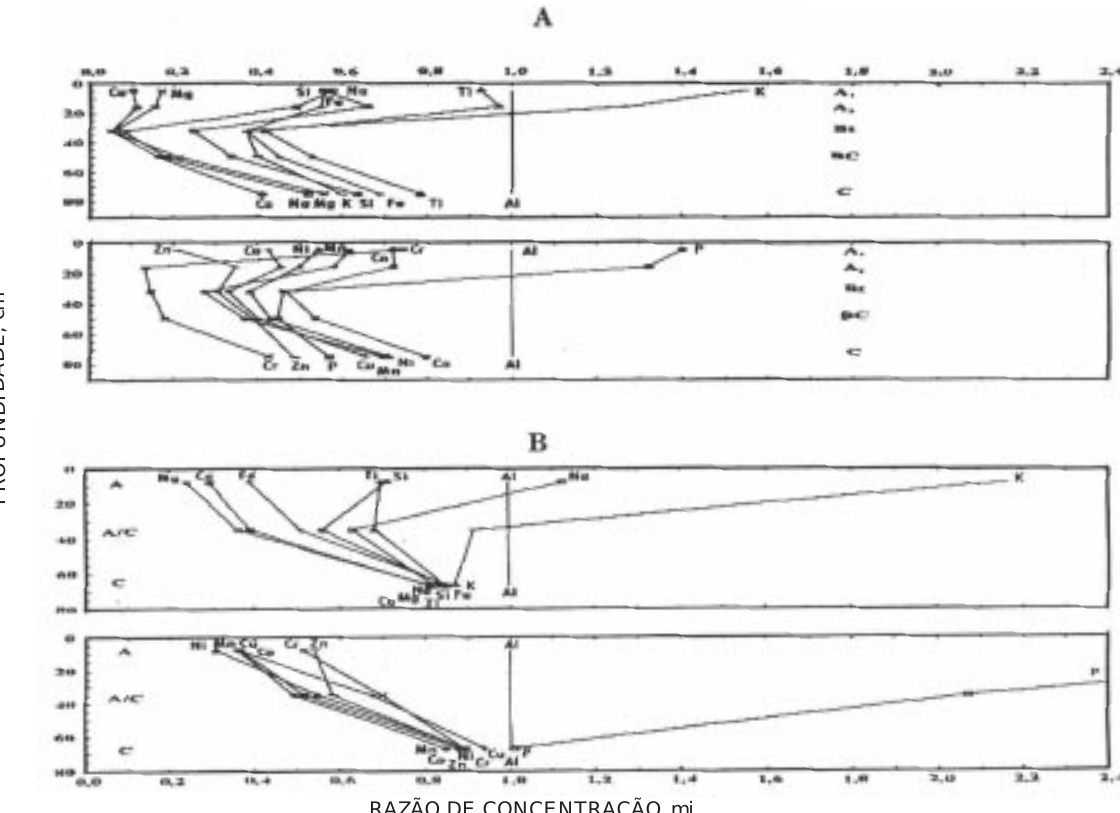
RAZÃO DE CONCENTRAÇÃO, mi Figura 2. Relação entre a razão de concentração dos elementos (mi) e a profundidade no perfil 1a(A) e perfil